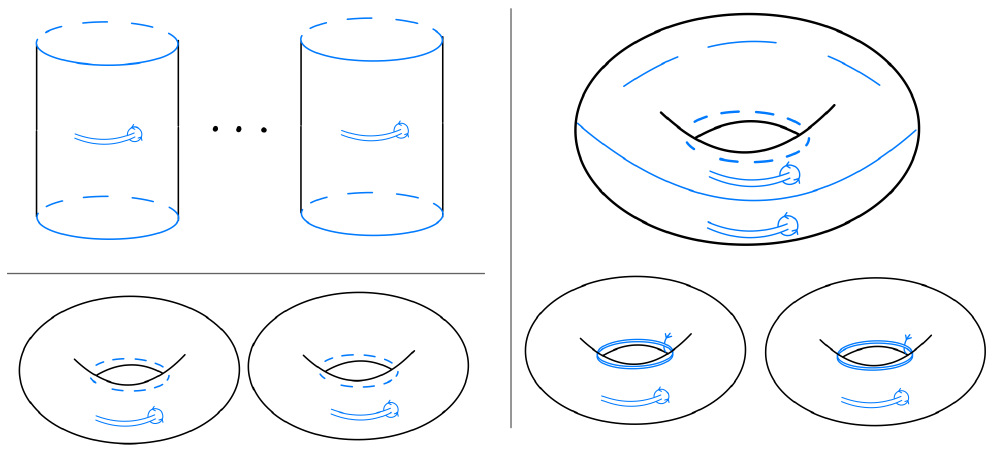
Figure 4 . Top left: n cylinders with a replicated line. All the cylinder’s boundaries are identified (dashed blue line). Bottom left: each cylinder is understood as a torus. τ = ± β between the n tori. Top right: stacking the n = 2 cylinders into a bigger torus with temporal periodicity 2 β . the circles at times τ = 0 , β are identified. Bottom right: the same topology can be drawn as n = 2 tori with another replicated circle at τ = ± β